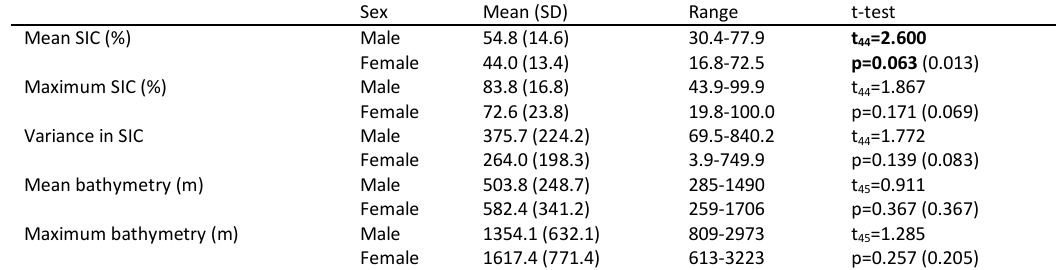
Table 3. Mean, maximum and variance in sea ice concentration, mean, minimum and maximum bathymetry for foraging localities of male and female snow petrels from Ile des Pétrels, Adélie Land, East Antarctica. For t-tests homogeneity of variances we checked using a Brown and Forsythe tests (Brown and Forsythe 1974), corrected p values are reported (uncorrected in brackets). Significant differences with a false detection rate of 0.10 are shown in bold.